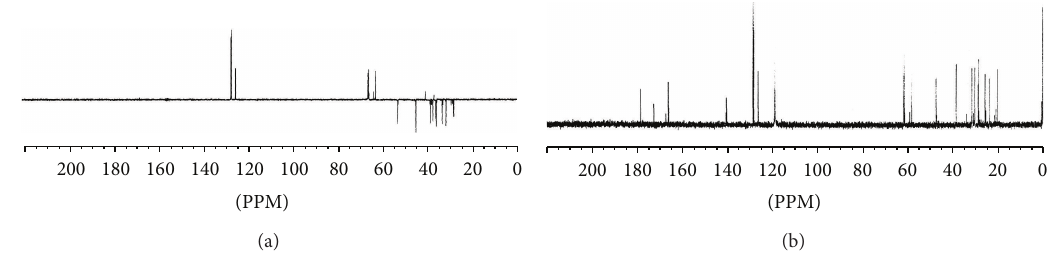
Figure 4: 13 C NMR spectrum of lisinopril in D 2 O/CD 3 CN (9/1, v/v). (a) Dep 135 t ,